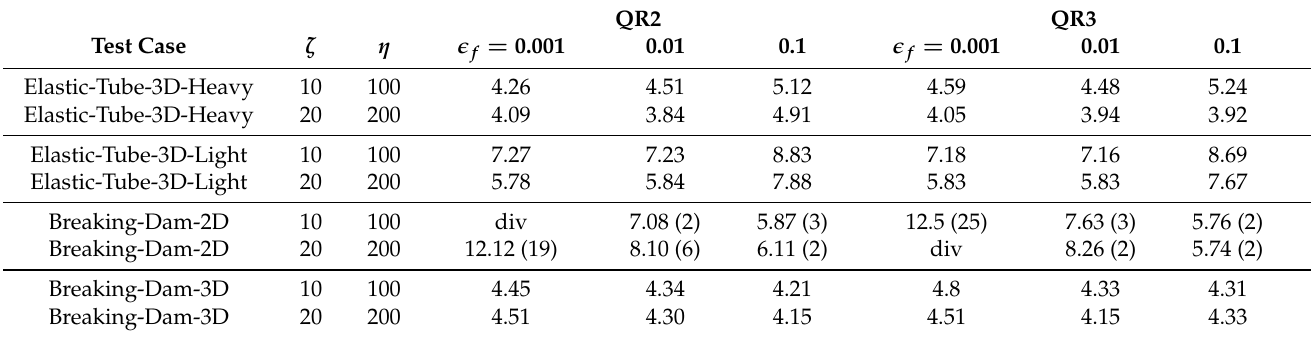
Table 3. Comparison of the average number of quasi-Newton iterations per time step for (i) pre- scaling update in every quasi-Newton iteration with the QR2 filter (column “QR2”), and (ii) the new pre-scaling weight monitoring approach with the new QR3 filter (column “QR3”). Three different filter limits (cid:101) f = 0.001, (cid:101) f = 0.01, and (cid:101) f = 0.1 are compared. Values in brackets indicate how many